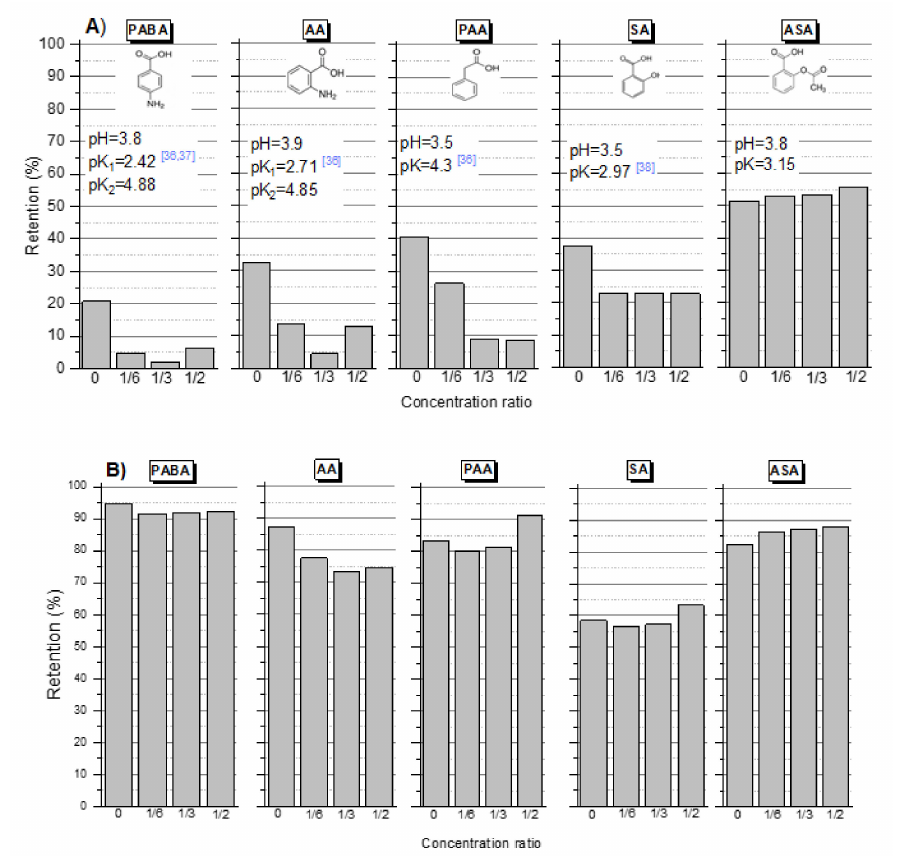
Figure 2. Retention value depending on the concentration ratio for selected compounds: ( A ) initial pH = 3.5–5; ( B ) pH = 8 (NaOH); membrane HL, pressure 1.0 MPa, temp. 30 ◦ C